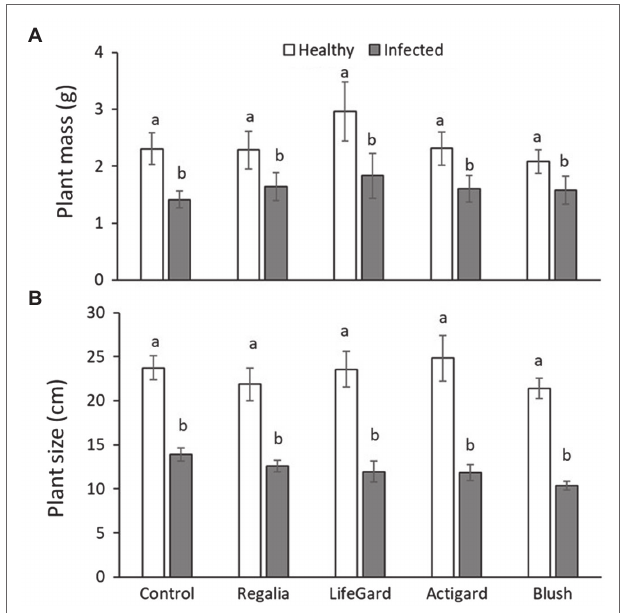
FIGURE 2 | Effects of phytoplasma infection and elicitor treatments on fresh mass (A) and size (B) of cranberry plants. Data are means ± SE . Different letters above bars indicate that means among elicitor treatments differ for uninfected (healthy) and infected plants [Tukey’s honestly significant difference (HSD); tests, p ≤ 0.05]. Control plants did not receive any elicitor (i.e., treated with distilled water only). n = 10 replicates per infection/treatment